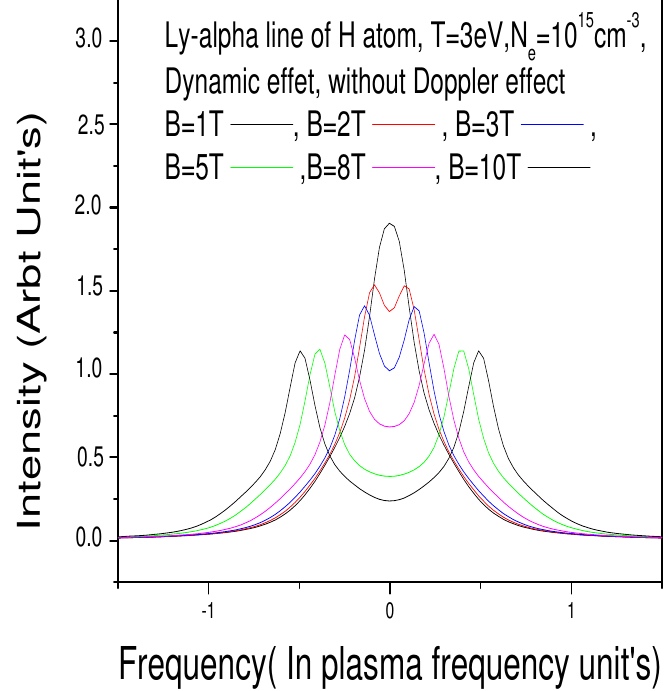
Figure 2. Lyman Alpha line in the hydrogen plasma with the Motional Stark Effect (MSE) and without the Doppler and fine structure effects.